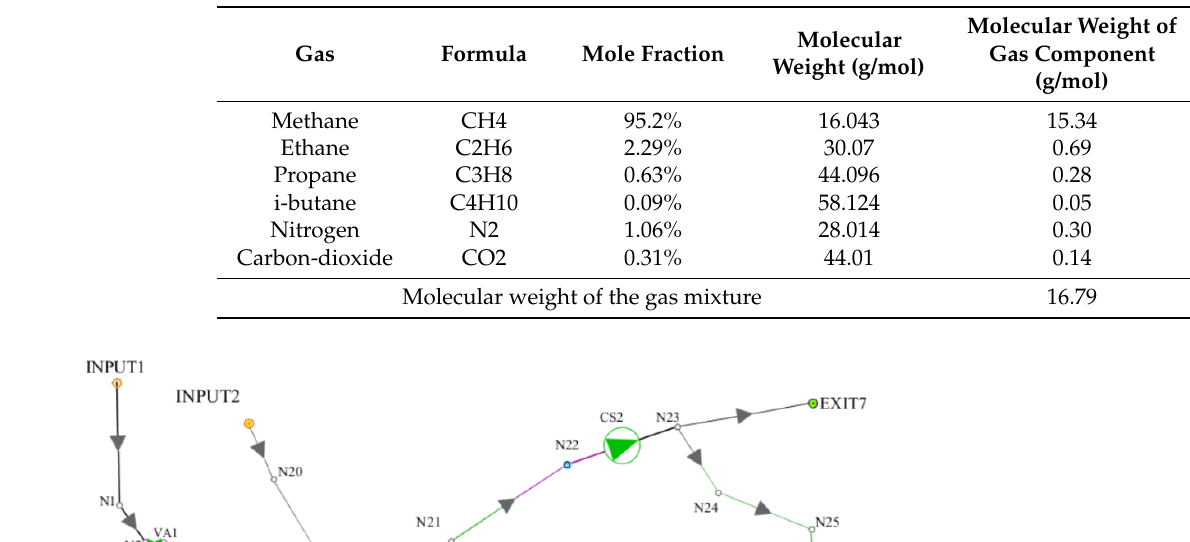
Table 1. Composition of the processed natural gas.